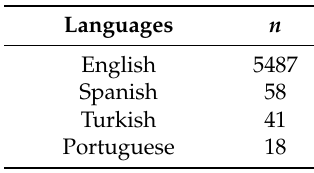
Table 2. Scientific language used.